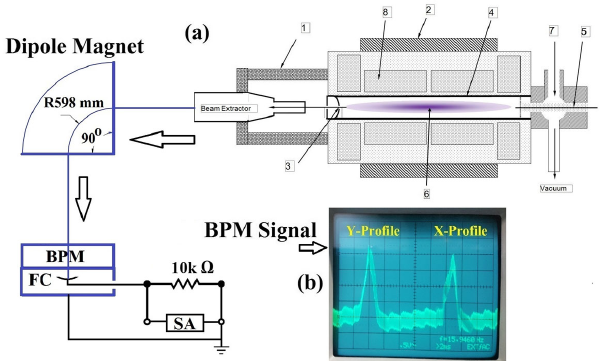
FIG. 1. (a) Schematics of ECR ion source with dipole magnet and beam diagnostics: 1 — high voltage insulator; 2 — source body; 3 — plasma electrode; 4 — plasma chamber; 5 – negative dc bias; 6 — ECR zone; 7 — rf injection line; 8 — permanent magnetic confinement both axial and radial. (b) Transverse beam profiles from BPM corresponding to maximum plasma instability